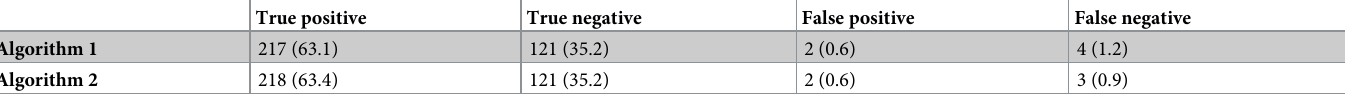
Table 5. Agreement between expert malaria microscopy and the two algorithms on the 344 conclusive test results. Algorithm 1 is: first reading HRP2-line and subse- quent confirmation with a p LDH-line; Algorithm 2 is: reading with a p LDH-line and confirmation with a